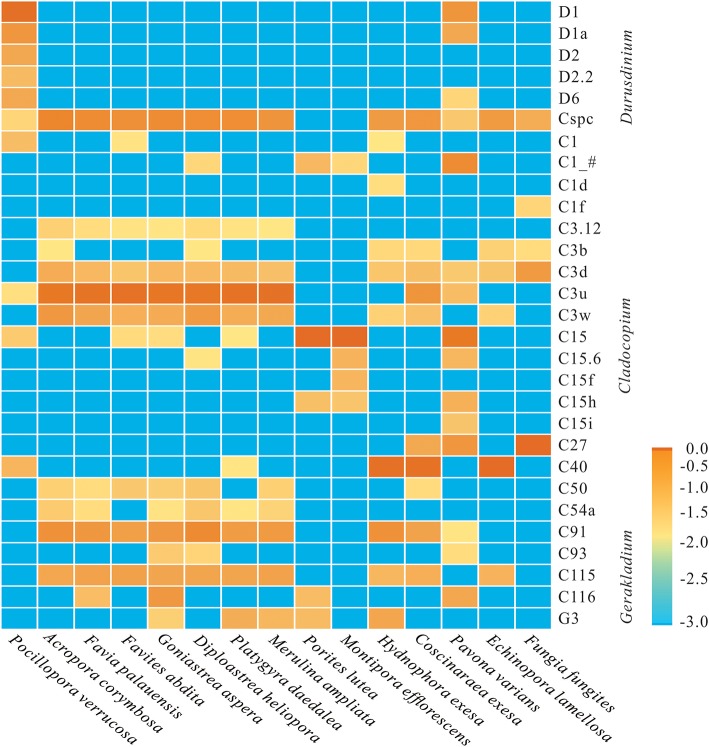
Log-scale percentage heatmap of the dominant/sub-dominant Symbiodiniaceae subclades among 15 coral species. The scales “−3.0, −2.5, −2.0, −1.5, −1.0, −0.5, 0” show the relative abundance at “0, 0.3, 1, 3.1, 10, 31, and 100%,” respectively. The average value was calculated using 3–5 replicates from each coral species.